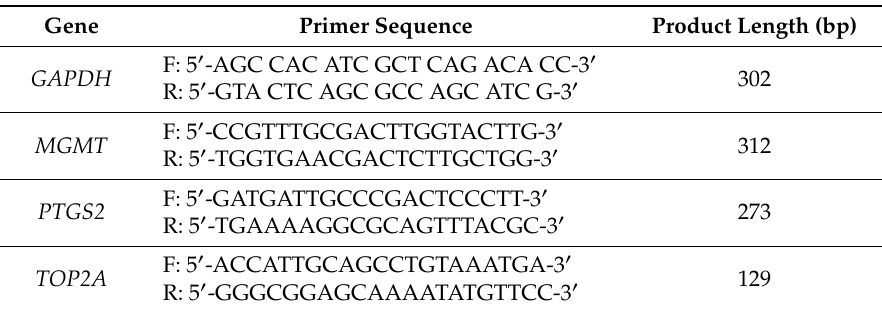
Table 3. Sequences of the primers used for